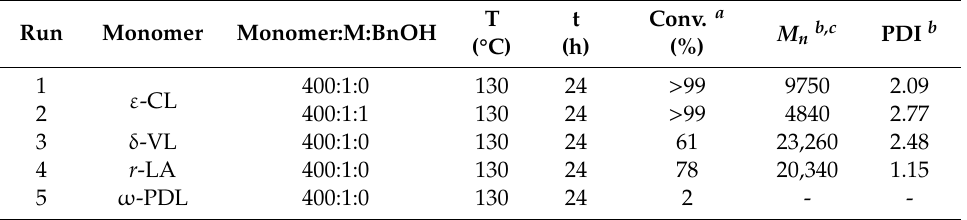
Table 22. Polymerization of cyclic esters catalyzed by Si-supported- 66 [29].